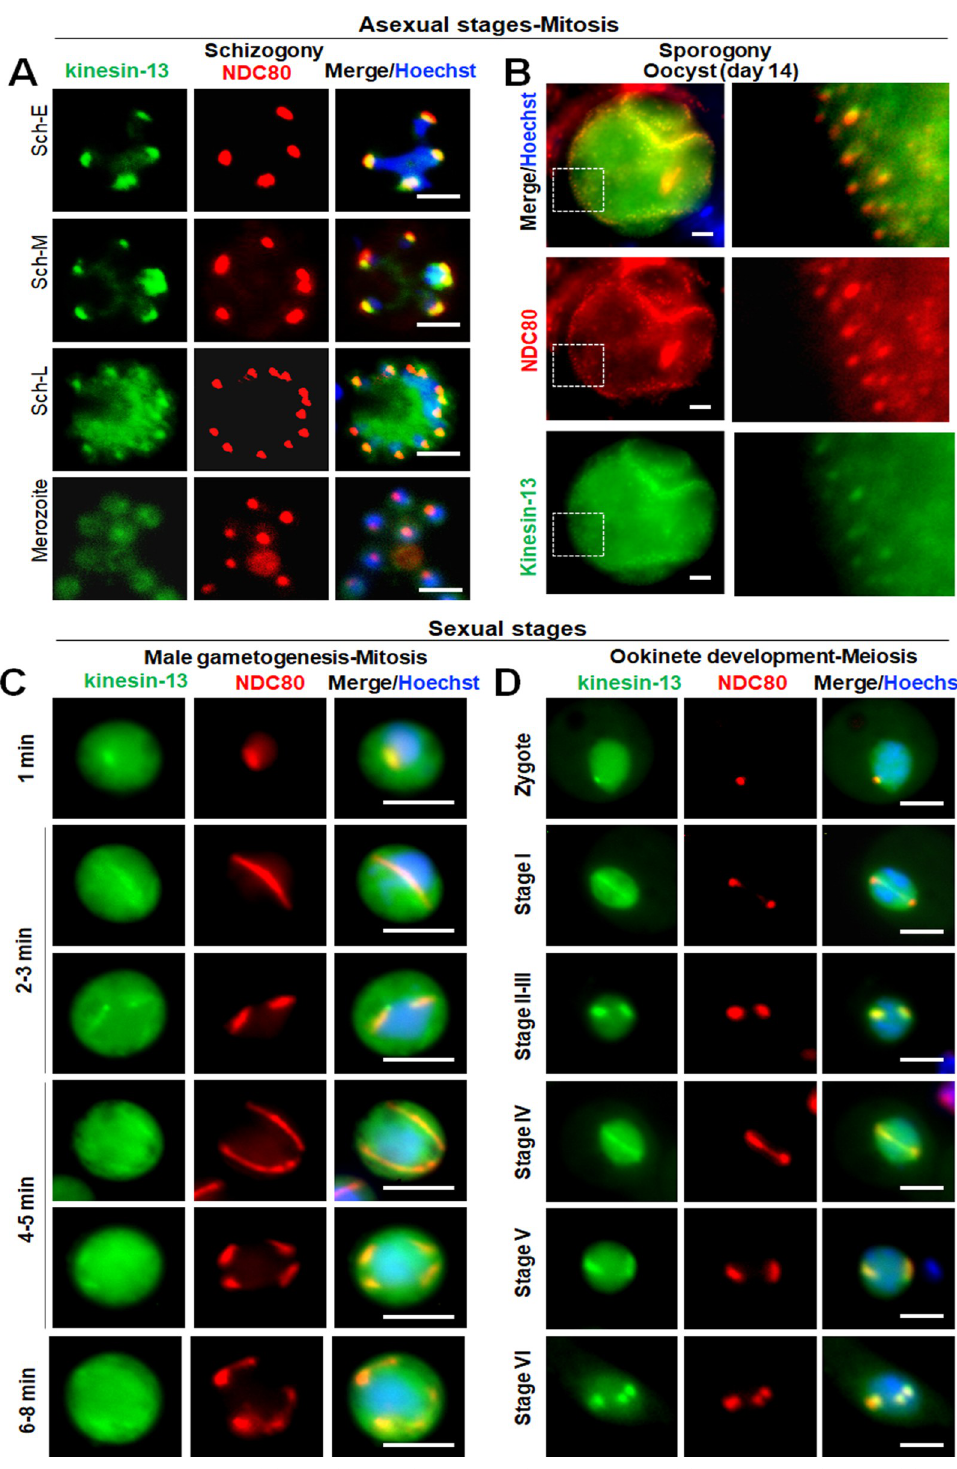
Fig 5. Kinesin-13 associates with kinetochore marker, NDC80, during various proliferative stages of parasite life cycle. Live cell imaging showing location of kinesin-13GFP (green) with respect to kinetochore marker NDC80Cherry (red) during asexual ( A , B ) and sexual ( C , D ) proliferative stages. Asexual proliferative stages include endomitosis during blood schizogony and sporogony. Sexual stages include endomitosis during male gametogenesis and meiosis during ookinete development. Kinesin-13GFP (green) shows a diffuse distribution in the cytoplasm, together with strong foci